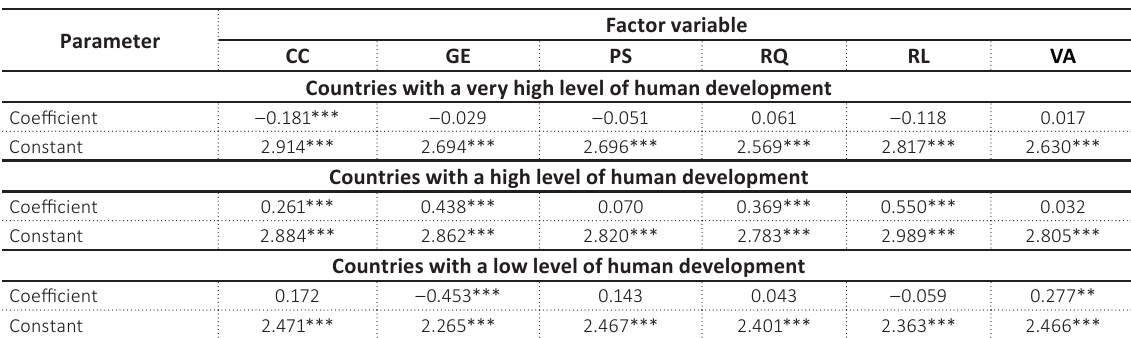
Table 3. The influence of governance quality on the level of independence of central banks among the countries with various levels of human